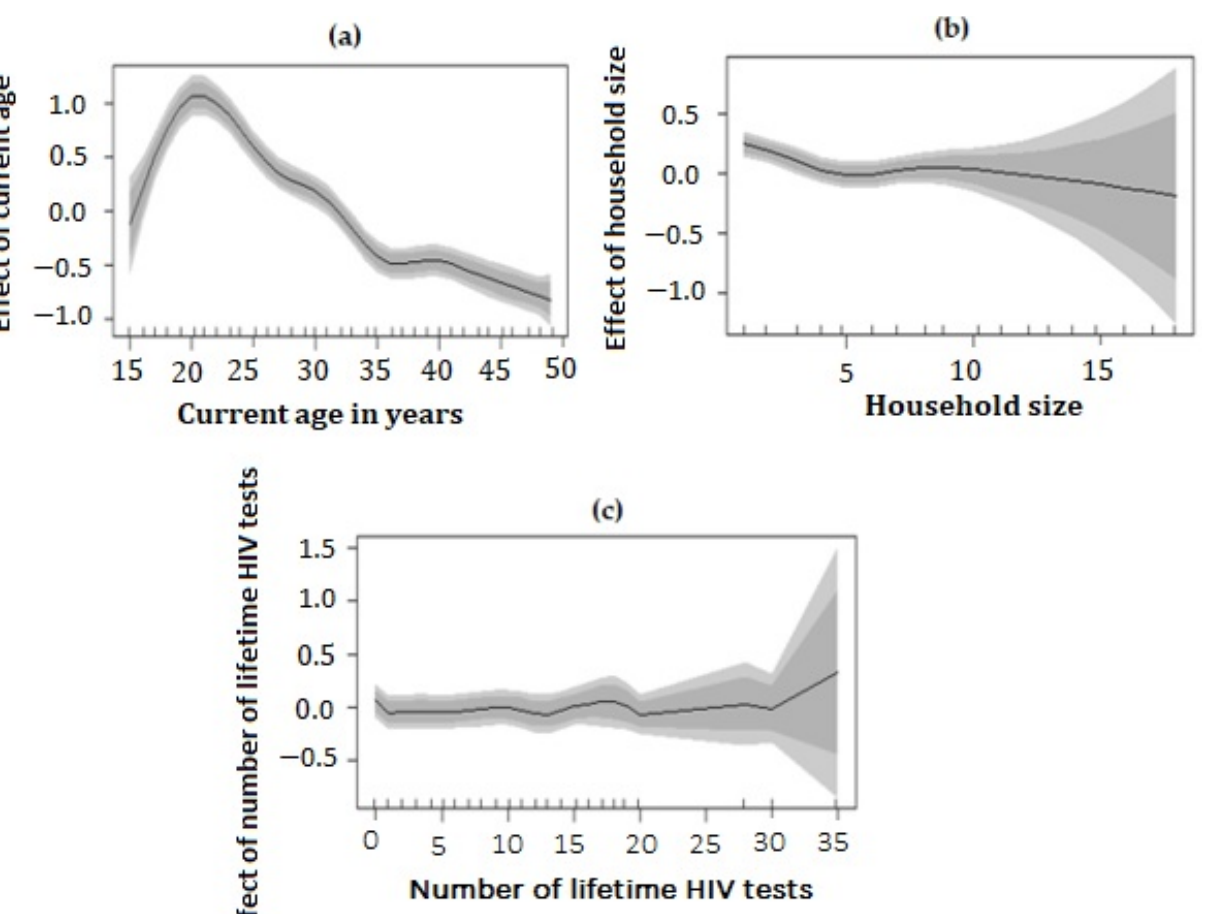
Figure 3. Estimated non-linear effects of ( a ) current Age (in years), ( b ) household size, and ( c ) number of lifetime HIV tests on the log-odds of unsuppressed viral load among HIV-positive men and women in Vulindlela (rural) and Greater Edendale (peri-urban) areas in uMgungundlovu District, KwaZulu-Natal Province, South Africa. The posterior means and 95% credible intervals are also shown by the shaded region.